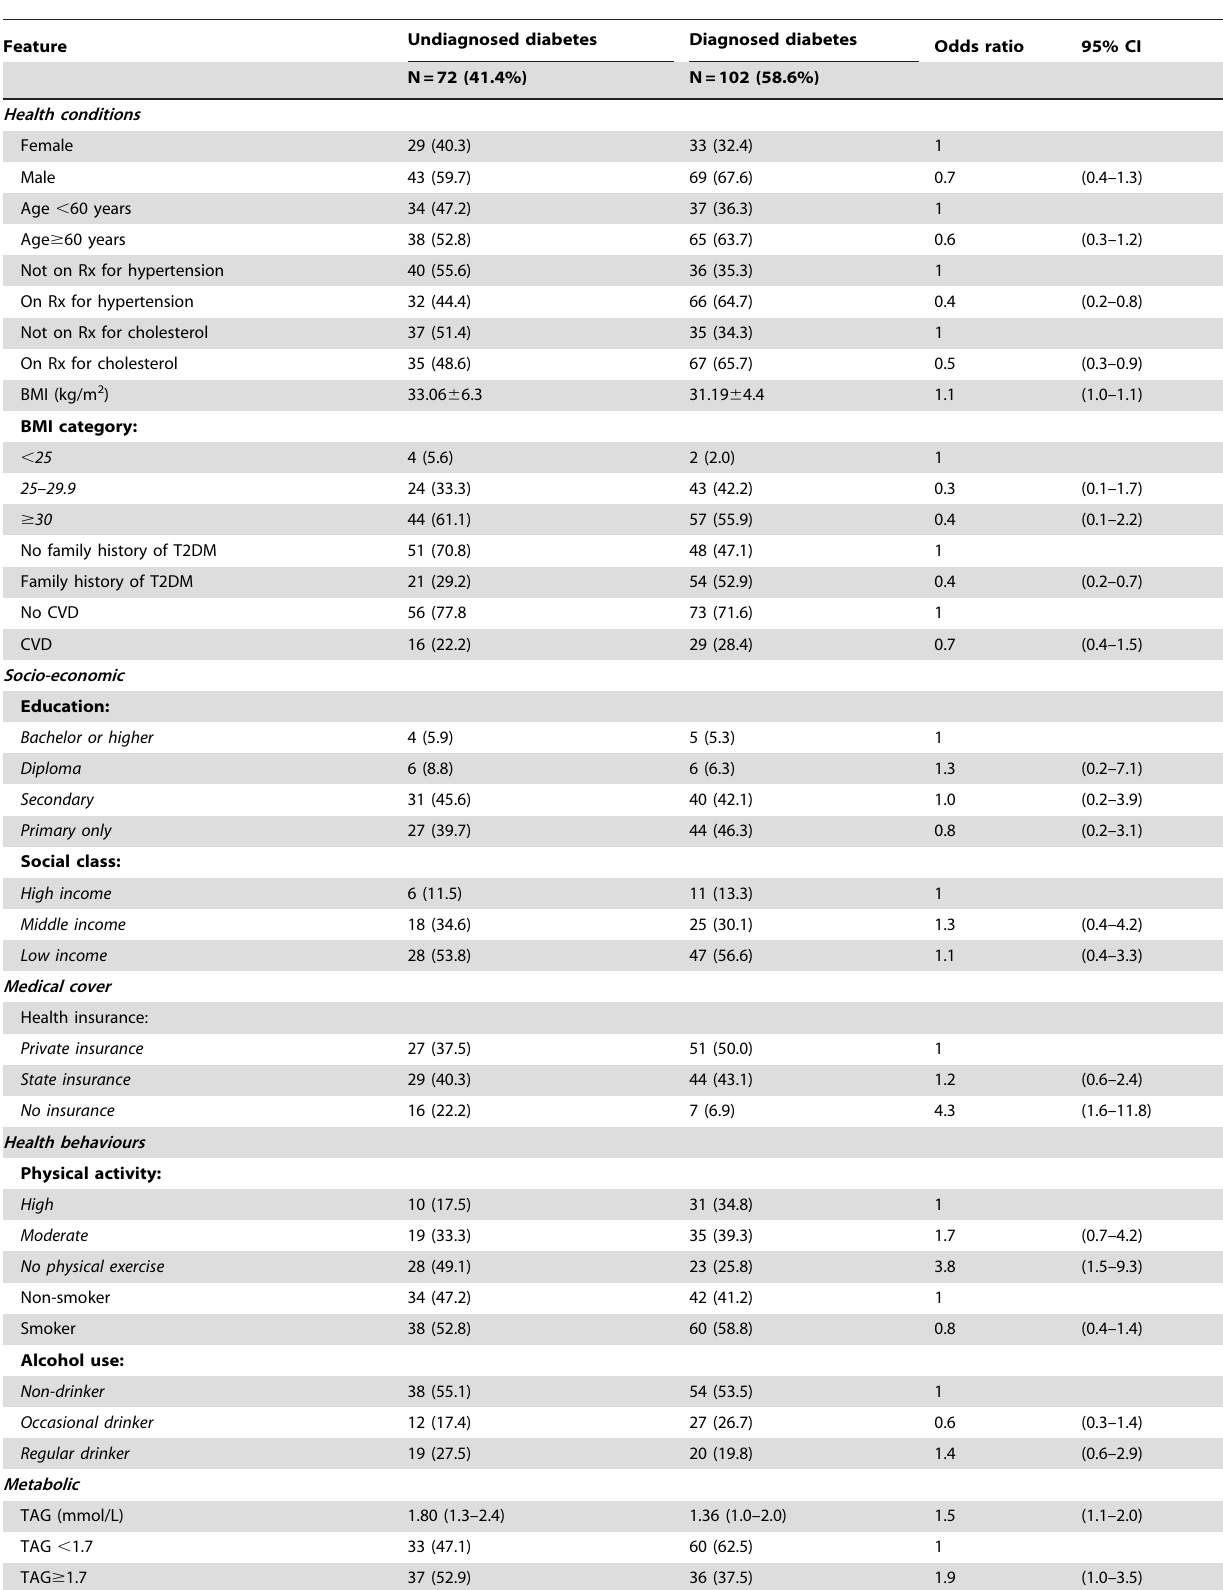
Table 3. Univariate odds ratios (95% CI) of having undiagnosed compared to diagnosed type 2 diabetes.